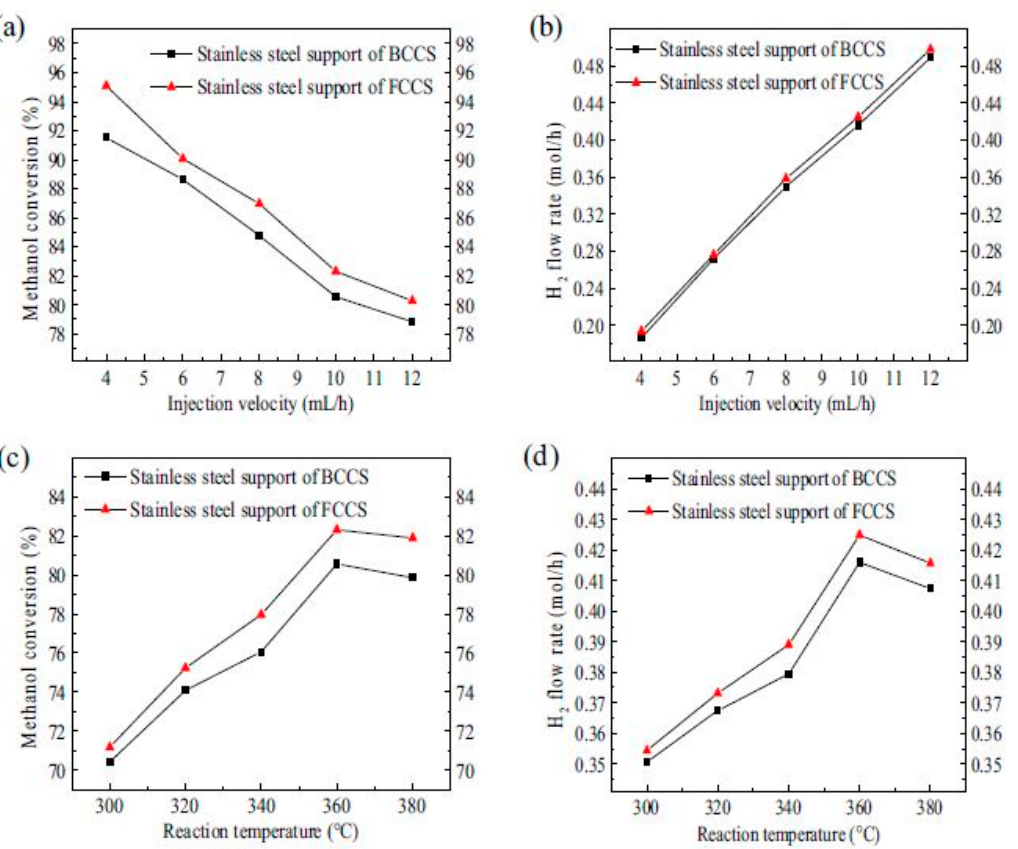
Figure 22. Reaction performances of microreactors with different 3D-printed porous stainless-steel supports for hydrogen production. ( a ) Methanol conversion. ( b ) H 2 flow rate under different injection velocities. ( c ) Methanol conversion. ( d ) H 2 flow rate under different reaction temperatures. Reproduced with permission from [181]. Copyright Elsevier, 2020.